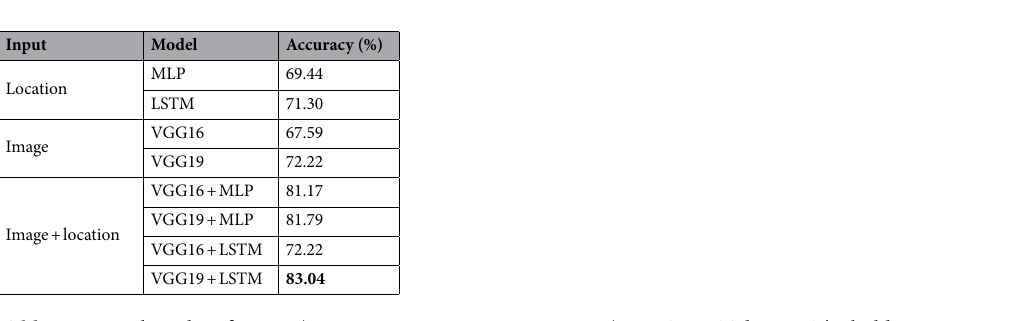
Table 12. Six-class classification (BG vs. N vs. D vs. P vs. S vs. A + V) on AZHMT dataset. The bold represents the highest results/accuracy achieved for each experiment.